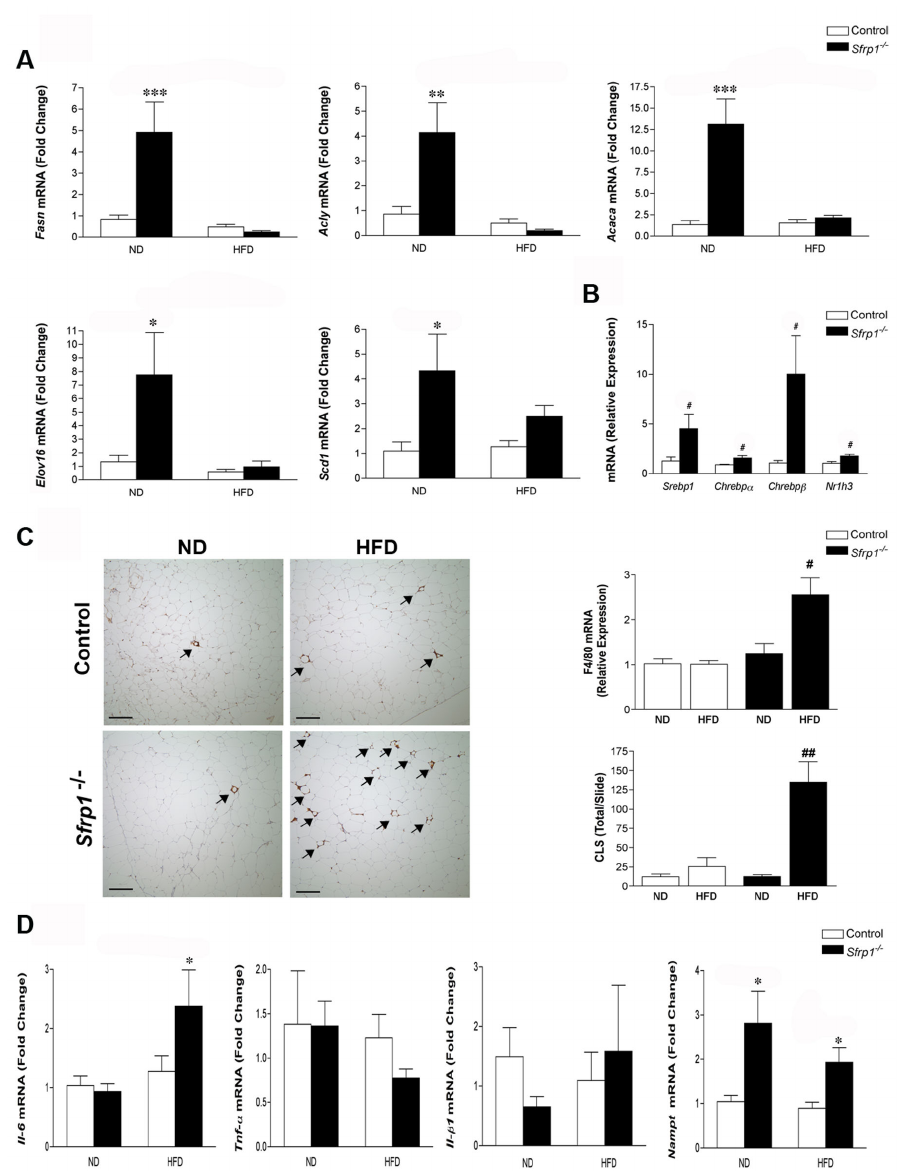
Figure 4. Analysis of de novo lipid synthesis and the inflammatory signature in the gonadal fat pad. (A) Total RNA from the gonadal fat pad in each group (n=6) was utilized for real-time PCR analysis of Fasn , Acly, and Acaca, Elov 16, and Scd 1 gene expression. The results shown represent experiments performed in duplicate and normalized to the amplification of β-actin mRNA. Bars represent mean ± SEM of the difference in fold change compared with control ND fed mice. (B) Real-time PCR was carried out utilizing RNA from the gonadal fat pad of control mice and Sfrp1 -/- mice on a ND to measure the relative mRNA expression of the following transcription factors: Srebp1, Chrebp-α , Chrebp -β, and Nr1h3 . The experiments were carried out as described above and bars represent mean ± SEM of the difference in fold change compared with control ND fed mice. (C) Left panel , gonadal fat pad sections were subjected to immunohistochemical analysis, stained for F4/80 (brown chromogen), and representative images were captured at 100X and are displayed for mice in each treatment group (scale bar 200 μm). Right upper panel , gondal fat pad RNA was used for real-time PCR analysis of F4/80 mRNA, experiments were carried out as described, and bars represent mean ± SEM of the relative expression with respect to ND fed mice. Right lower panel , The total number of CLSs (see arrow inset) were counted in F4/80 stained gonadal fat pad sections (n=4/genotype) (D) Real-time PCR analysis of liver Il-6 , Tnf -α, Il-1β, and Nampt gene expression was carried out as described above. Bars represent mean ± SEM of the difference in fold change compared with control ND fed mice. (*p<0.05, **p<0.01, ***p<0.001 significantly different from control mice fed a ND using Bonferroni’s t test after a two- way ANOVA; # p<0.05, ## p<0.01, significantly different from respective ND fed mice using student’s t test.). doi: 10.1371/journal.pone.0078320.g004 PLOS ONE |